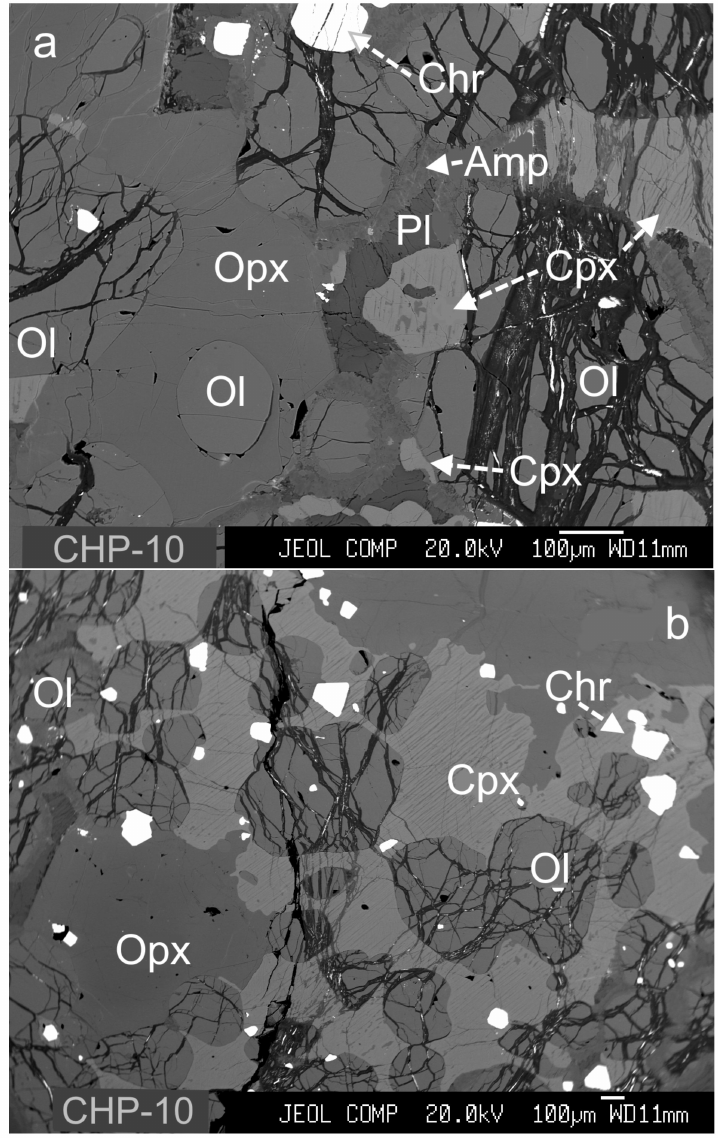
Figure 9. ( a , b ). A BSE image shows a corona-type texture composed of olivine (Ol), orthopyroxene (Opx), clinopyroxene (Cpx), and amphibole (Amp), in a specimen of fresh harzburgite, another